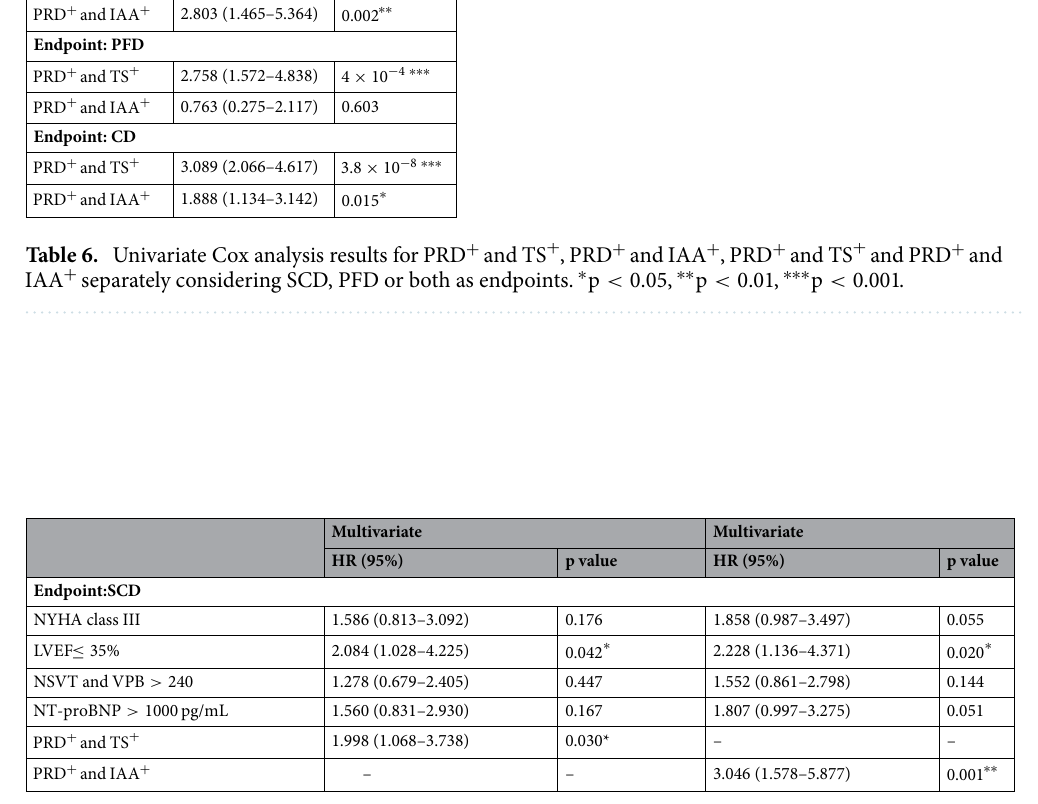
Table 7. Multivariable SCD risk prediction including the following variables: NYHA class, LVEF ≤ 35% , combined NSVT and VPB > 240 , NT-proBNP > 1000pg/mL and a combined ECG variable that can be either PRD + and TS + or PRD + and IAA + . ∗ p < 0.05 , ∗∗ p < 0.01 .